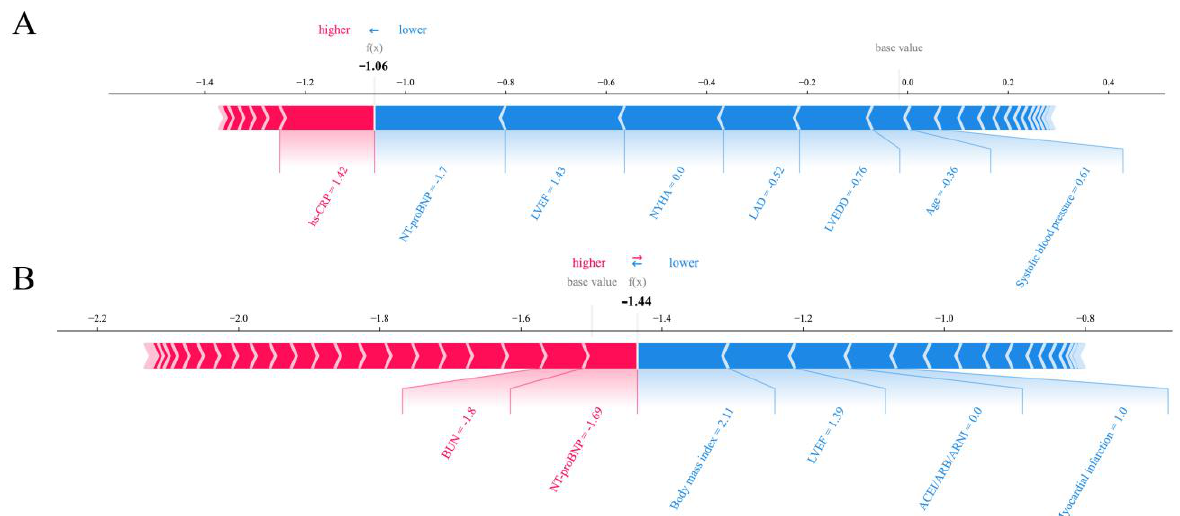
Figure 4. SHAP force plots for XGBoost predicting all-cause death ( A ) and SSVM predicting shock ( B ) in a single patient. Red and blue bars respectively represent the positive and negative effects of each predictor contributing to the occurrence of the outcome. The extent of impact is represented by the size of the bar. Bold values represent the predicted risk scores. Of note, values have been transformed 3.